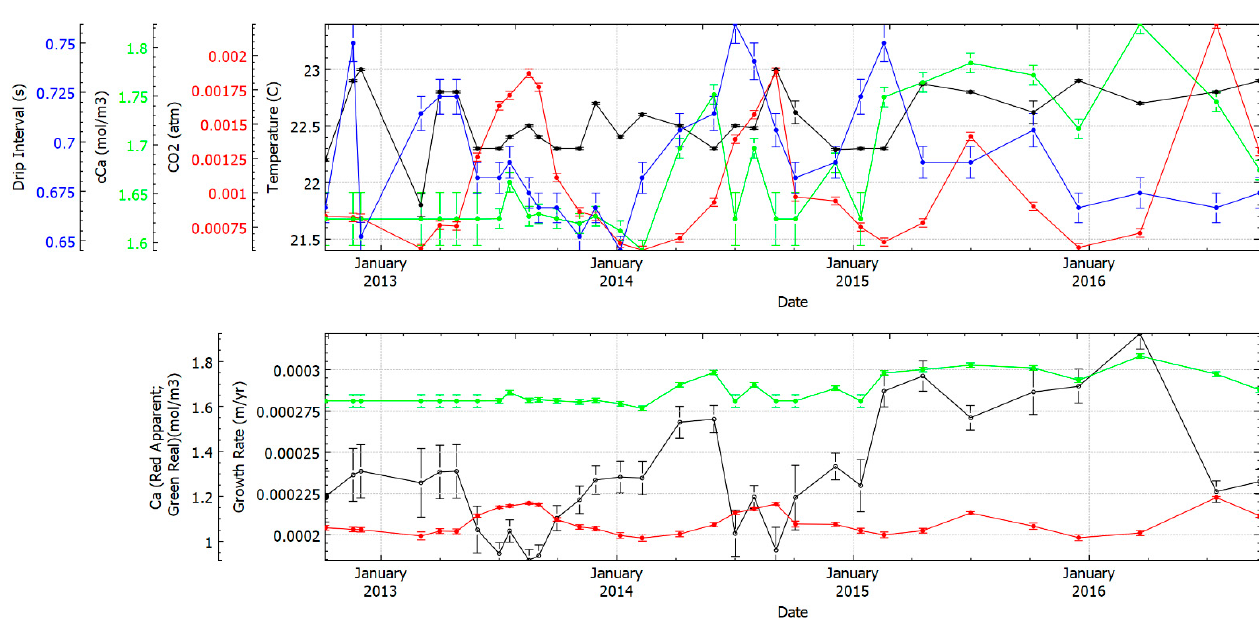
Figure 4. StalGrowth applied to Larga Cave drip site LA2. The top plot shows the input parameters and the bottom plot shows the output of StalGrowth (see Figure 1 for more detail).